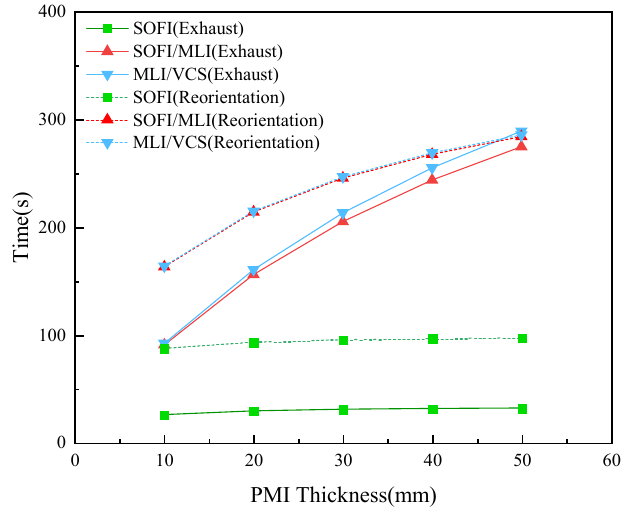
Figure 11. Acceleration by exhaustion of TVS. For the target tank, the pressure control band of TVS is ± 3.45 kPa, with a filling rate of 20% and a duty cycle of 5%. The exhaust time and needed reorientation time of TVS under different PMI thicknesses are shown in Figure 12. In most cases, the TVS exhaust time is less than the time required for reorientation, and it is hard to achieve reorientation. However, when the thickness is 50 mm of the common bulkhead at the heat leakage of 12.7 W/m 2 (see Figure 12), the fluid of the MLI/VCS insulation tank can be reorientated by evaporated exhaust gas.